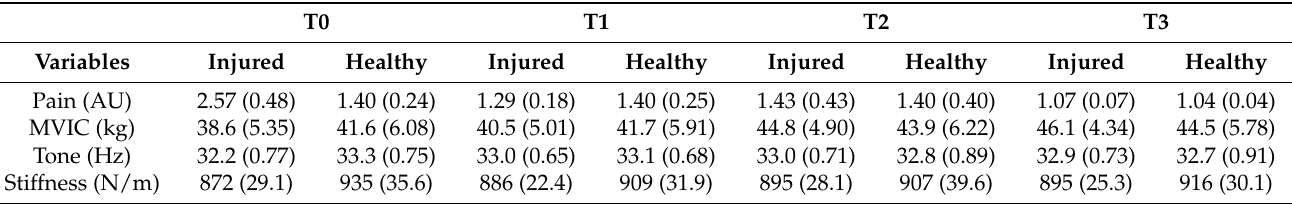
Table 1. Functional and viscoelastometric